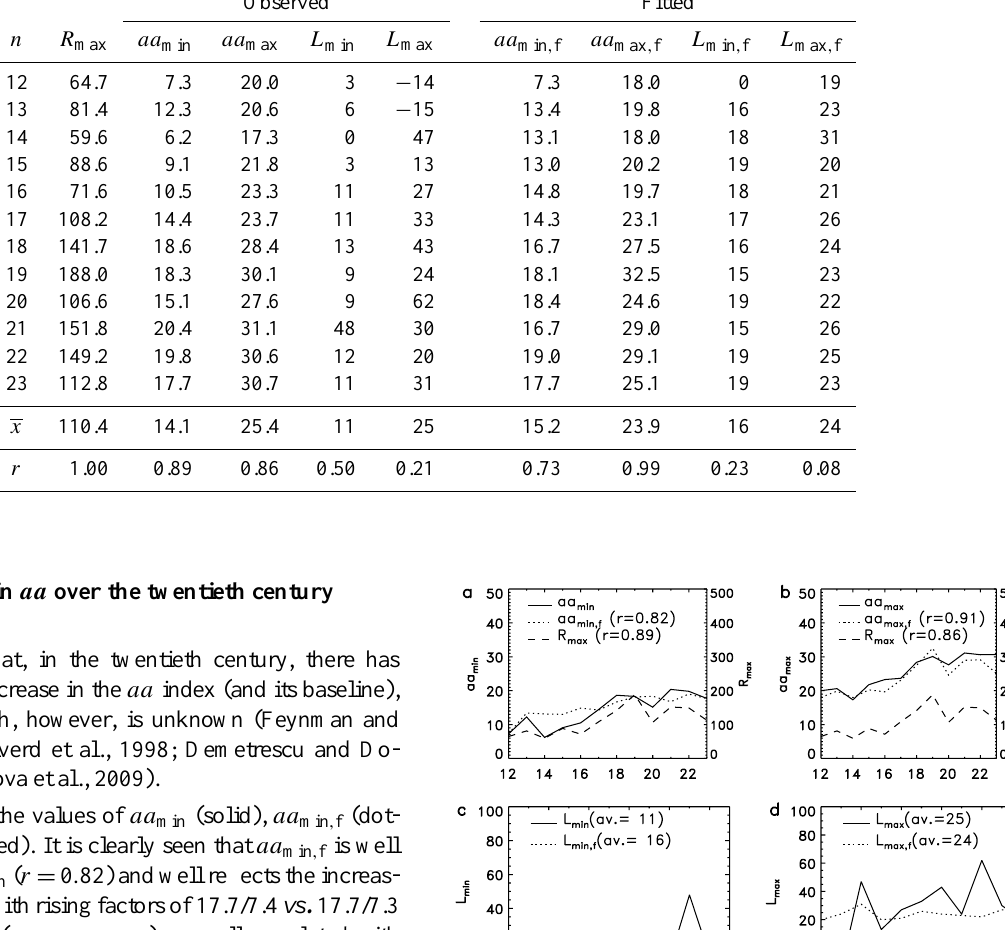
Table 1. Geomagnetic minimum ( aa min ), maximum aa ( aa max ), lag times of aa to R z at minimum ( L min ) and at maximum ( L max ) for Cycles n = 12–23, and the corresponding values ( aa min , f , aa max , f , L min , f , L max , f ) from the reconstructed series (10). The last two rows show the averages of these values and the correlation coefficients ( r ) of these values with the maximum amplitude ( R max ) of sunspot cycle. Observed Fitted n R max L min